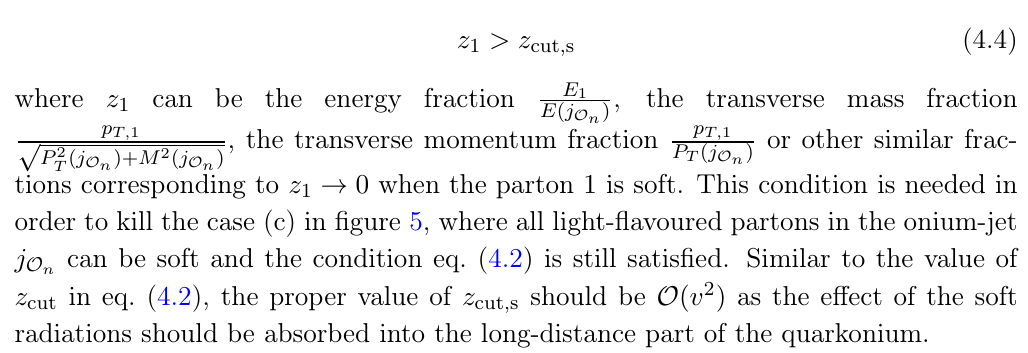
and the last one is for the light-flavoured O n